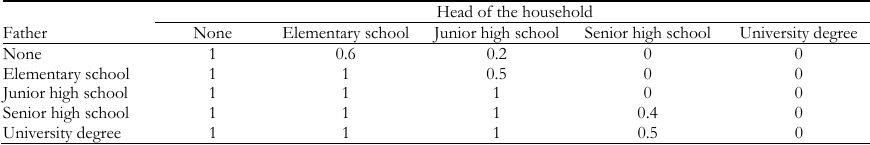
Head of the household